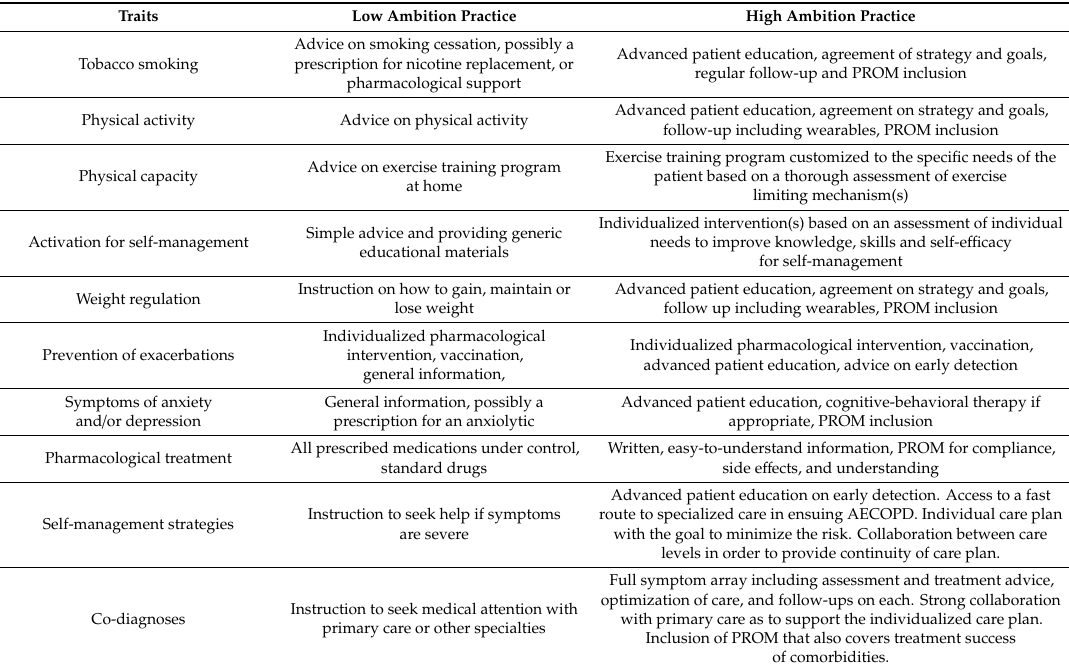
Table 1. Increasing the ambition of continuity, patient involvement and understanding compliance often entail patient education and increased focus on patient-reported outcome measures (PROMs) as a